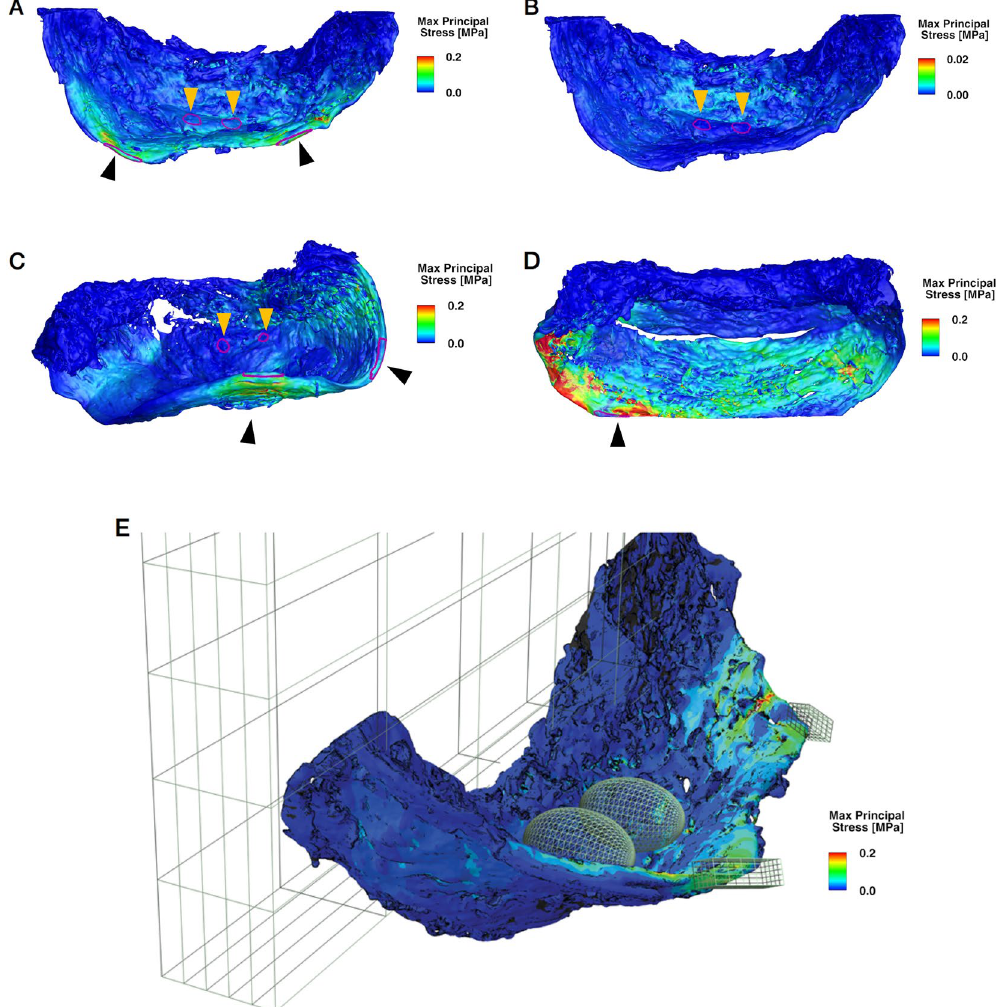
Figure 3. Finite element simulations results showing the maximum principal stress at the end of each linear static loading scenario. ( A , C , E ) Showing worst case loading scenarios, namely two eggs and two birds positioned on the nest rim to apply a maximum bending moment on the nest’s fixation to the wall. ( A – D ) Showing top view of loading scenarios. ( A ) Worst case loading scenario with two adult birds and two eggs. Black arrowheads indicating bird standing positions on nest rim. ( B ) Loading scenario with two eggs and no birds. Orange arrowheads indicating egg positions. It is clear that the “egg-region” is experiencing lower values of stress. ( C , D ) Effect of damaged sites in the structure on the response to loads, showing that the stress was localized along fault lines that originate at those sites. Arrowhead indicates position of loading. Panel D shows that the anchor region is mostly isolated from the stresses induced by loading from the positions indicated by black arrowheads. ( E ) The FE model result of maximum principal stress of the nest under a complete loading scenario. ROIs’ are shown to highlight the regions where loading is applied. Birds are represented by cuboid ROIs on the nest rim, eggs as ellipsoid ROIs and anchoring area is presented within the grid